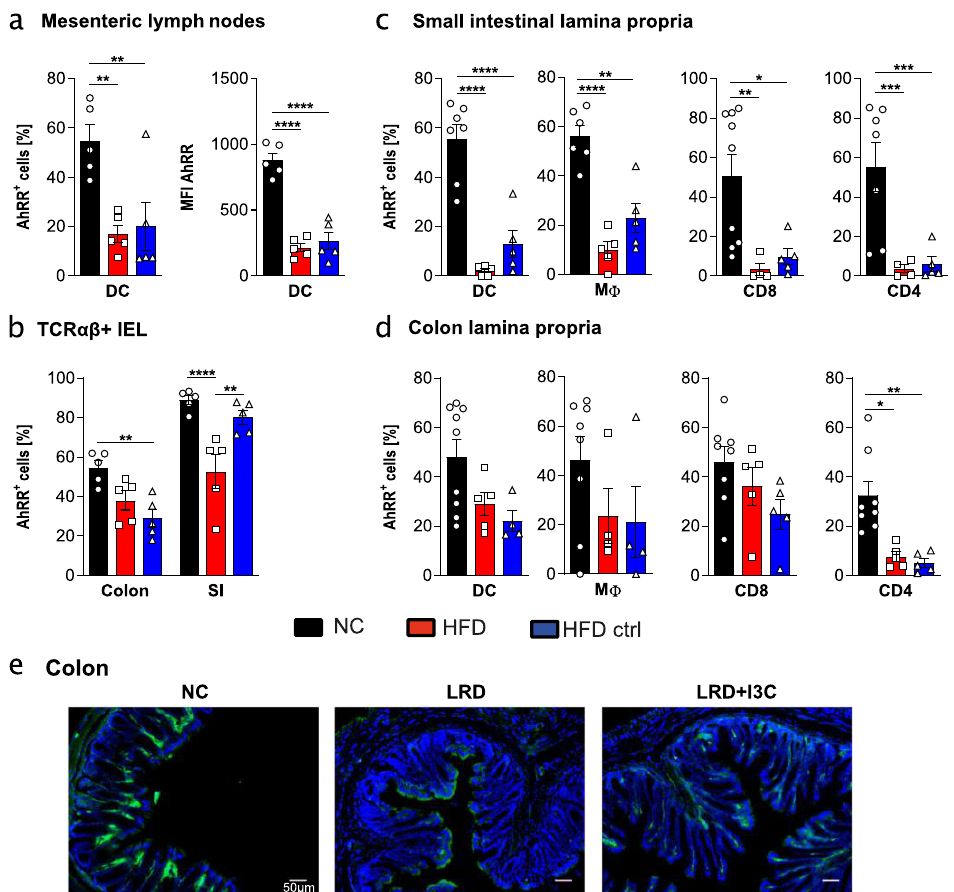
Figure 3. High fat diet and control diet lead to reduced expression of Ahrr in intestinal immune cells. AhRR E /+ mice were fed for four weeks from weaning onwards with normal chow (NC), high fat diet (HFD), or a matched HFD control diet (HFD ctrl). Frequency of Ahrr expressing DCs and MFI of DCs in the mLNs ( a ); frequency of Ahrr expressing TCR αβ + IELs (intraepithelial lymphocytes) in colon and small intestine (SI) ( b ); and frequency of Ahrr expressing DCs, M Φ , CD4 + T cells, and CD8 + T cells isolated from the lamina propria of SI ( c ) and colon ( d ). ( e ) After PFA fixation, cryosections of the colon were stained with DAPI in addition to the endogenous EGFP reporter. Data are pooled from at least two independent experiments ( n = 5–9). Results are shown as mean +/ − SEM and significance was analyzed by one-way ANOVA corrected for multiple comparisons by the Tukey’s post hoc test (* p < 0.05, ** p < 0.01, *** p < 0.001, **** p < 0.0001). Pictures are representative of at least three different mice from at least two independent experiments.